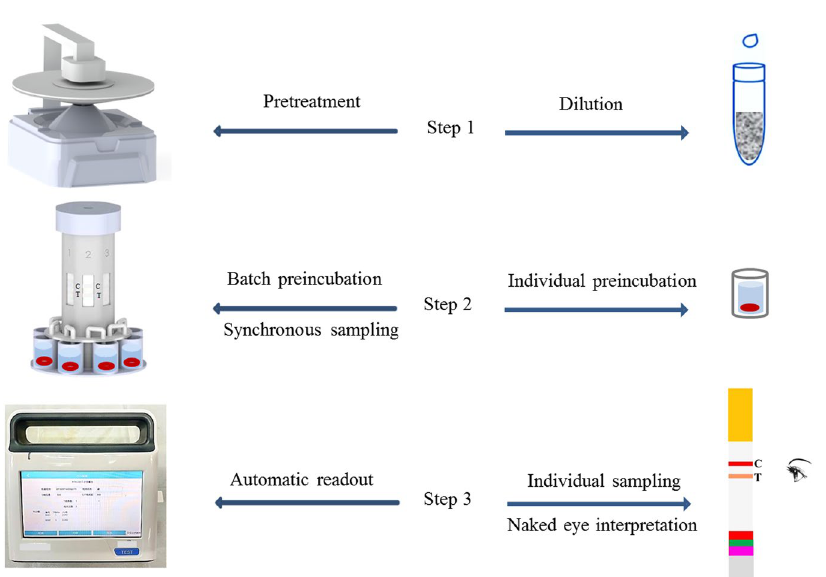
Figure 2. Comparison of the ICA process in this work (left) and the traditional approach (right). Step 1 shows the pretreatment of the milk sample. Three pretreatment methods were investigated and performed